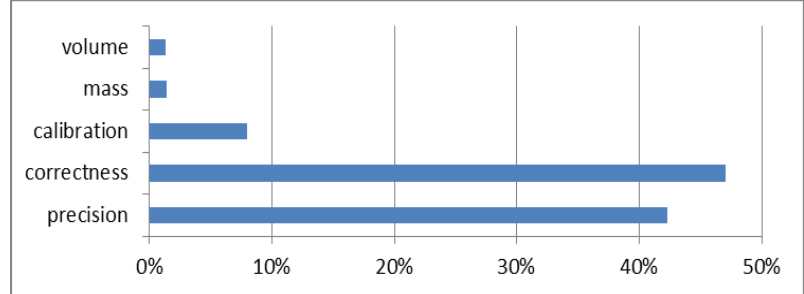
Figure 2. Percentage of components in the uncertainty budget for a silicon content of 0.1 – 10%.